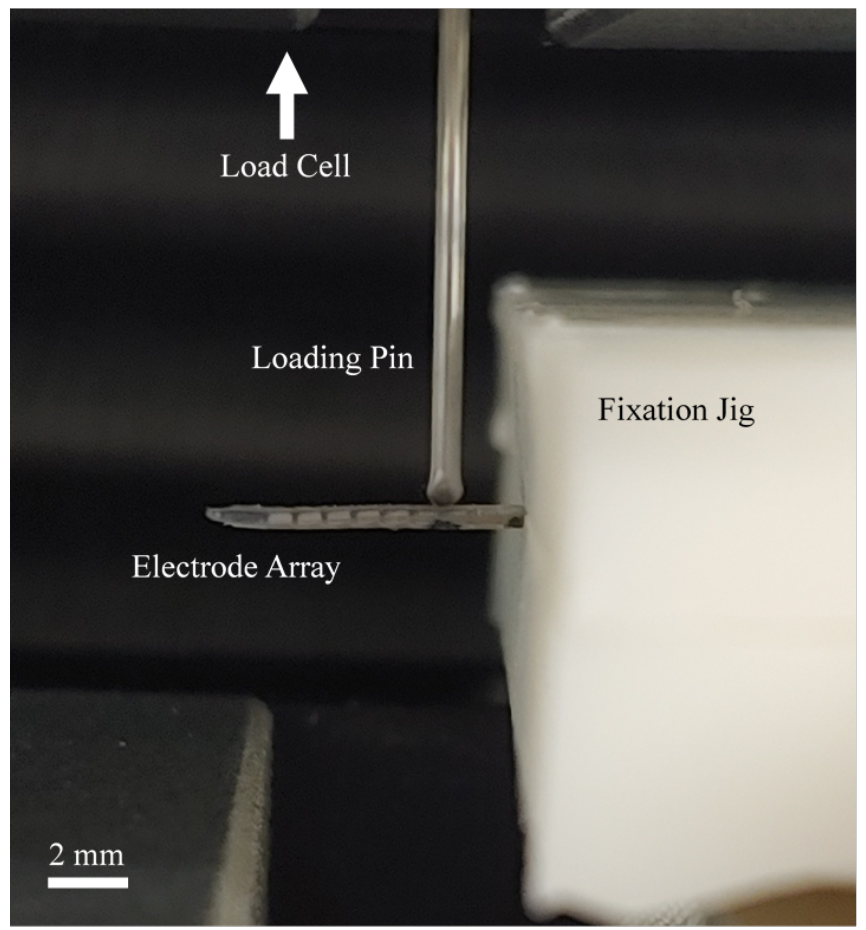
Figure 3. Deflection force measurement. The electrode arrays were fixed to a custom fixation jig, and a loading pin attached to a load cell was used to bend the electrode array 30 ◦ at a distance of 2 mm from the fixed